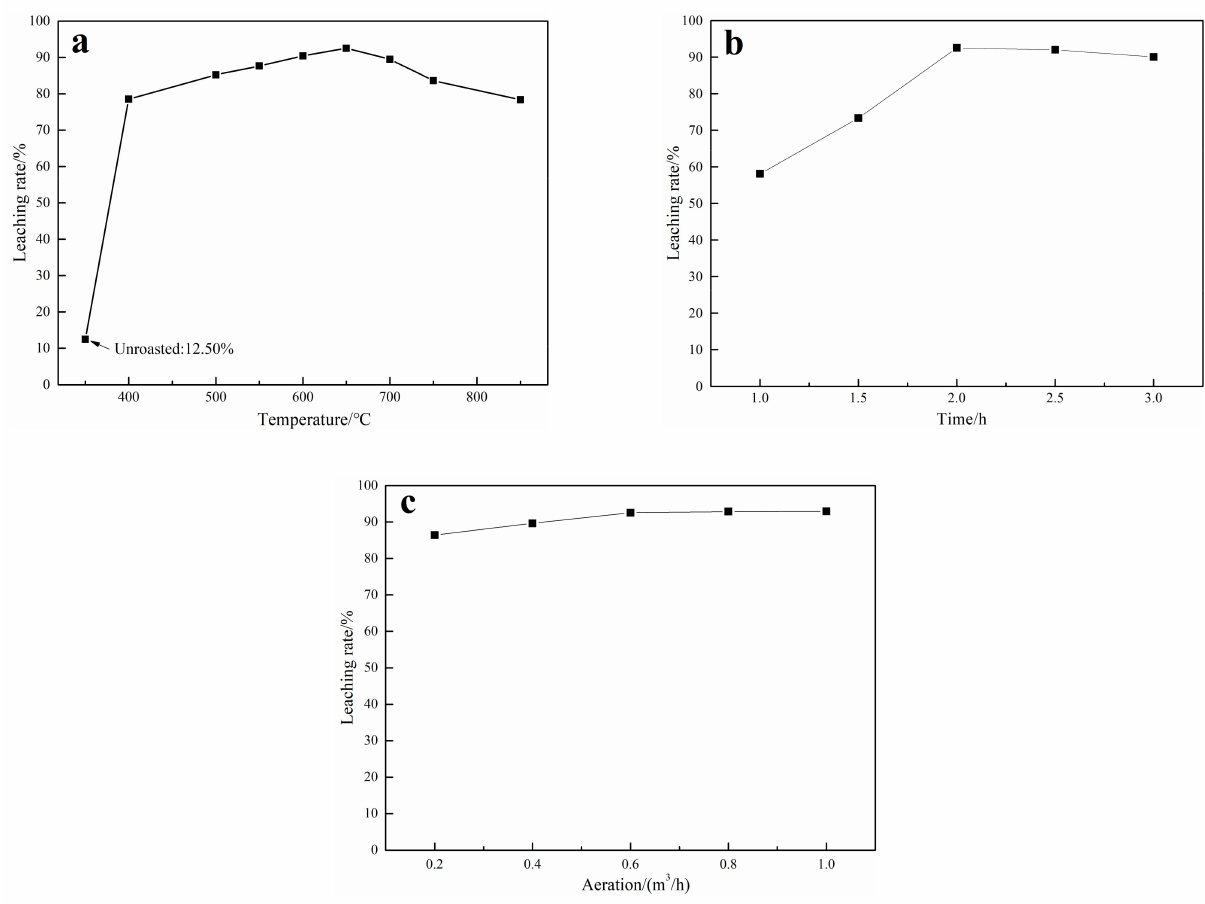
Figure 2. Effects of roasting temperature, roasting time, and ventilation rate on the gold leaching rate. ( a ) temperature; ( b ) time; ( c ) ventilation